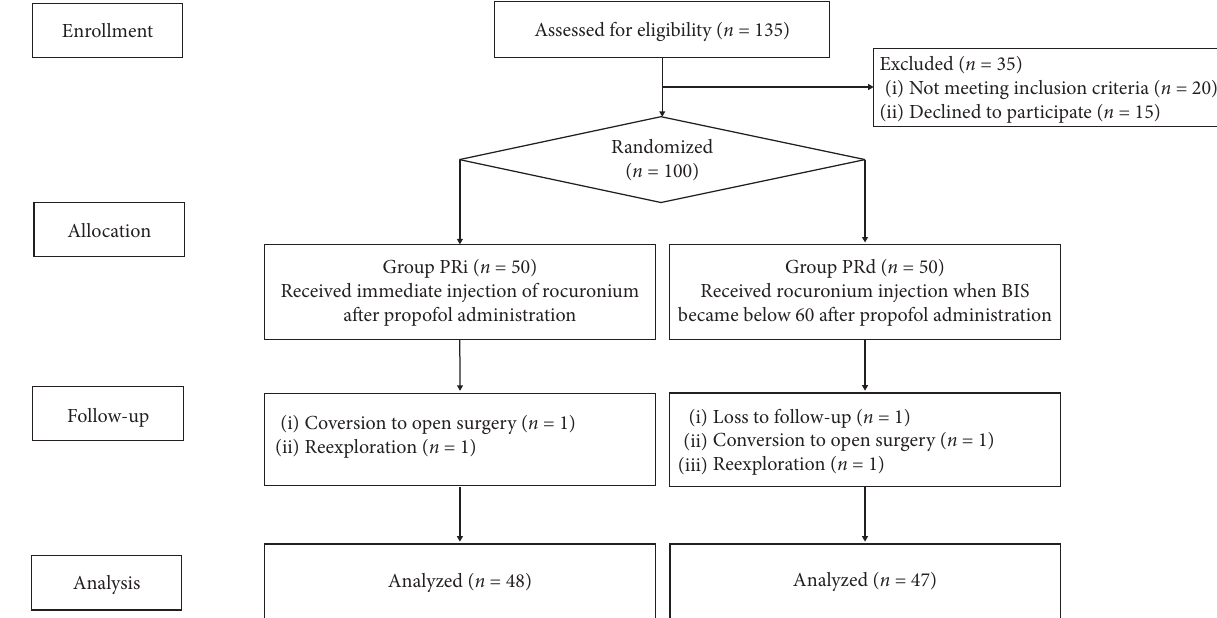
Figure 1: Consort flow